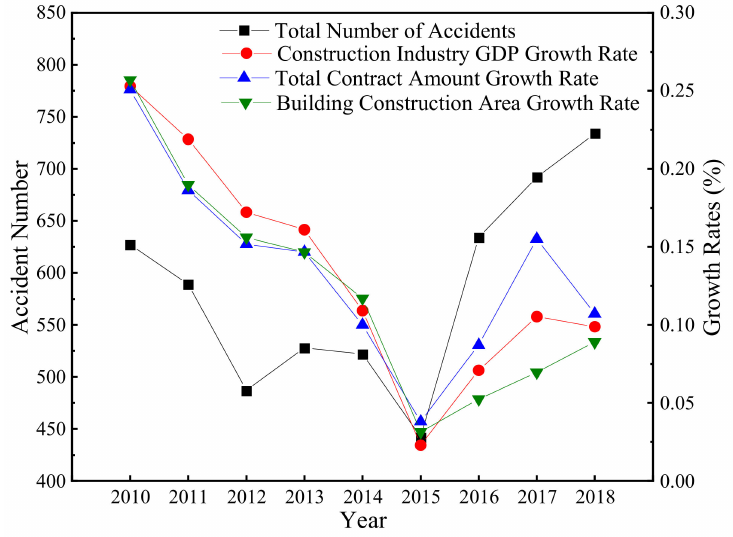
Figure 2. Comparison between number of accidents and other